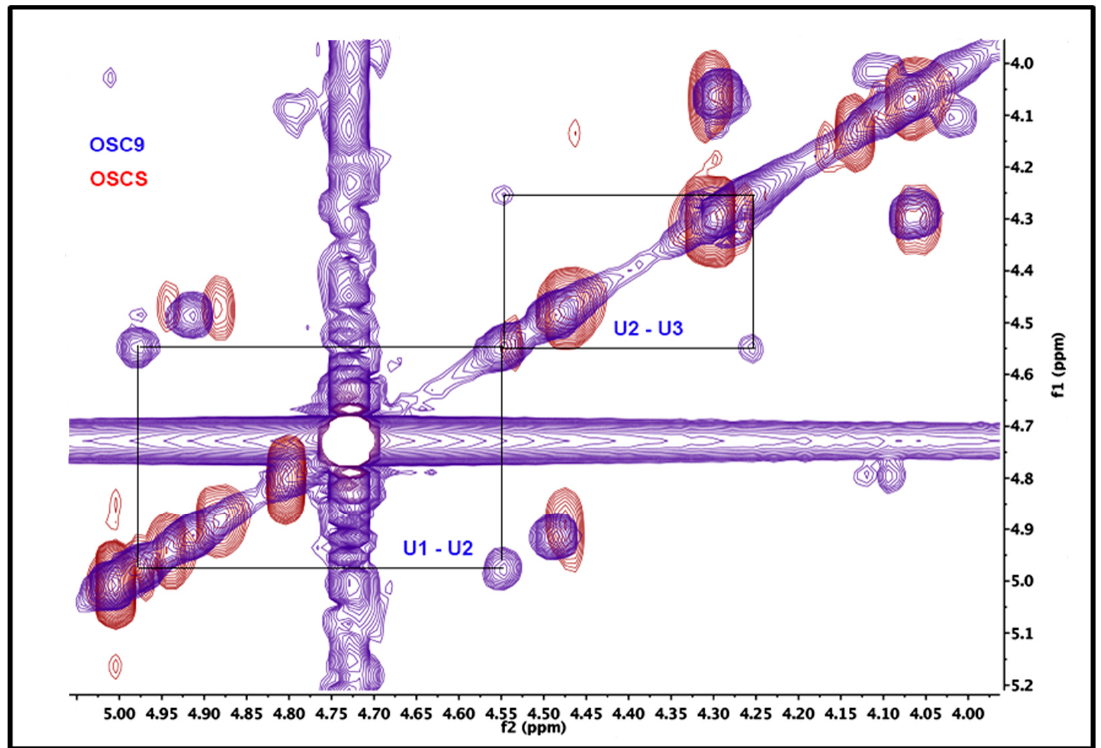
Figure 7. Two-dimensional NMR COSY spectra for the standard OSCS and the isolated OSC9. 1 H NMR spectroscopy and 1 H 1 H two-dimensional COSY homology was performed according to the USP monograph for sodium heparin. In the OSCS COSY spectra (red), the U2-U3 correlation signal is shifted, as expected, downfield since position 3 is replaced by a sulfate (electronegative) group. On the other hand, the OSC9 COSY spectra (blue) shows a downfield unlinked U2-U3 correlation signal which suggests the complete non-sulfation at the 3-position of the glucuronic acid